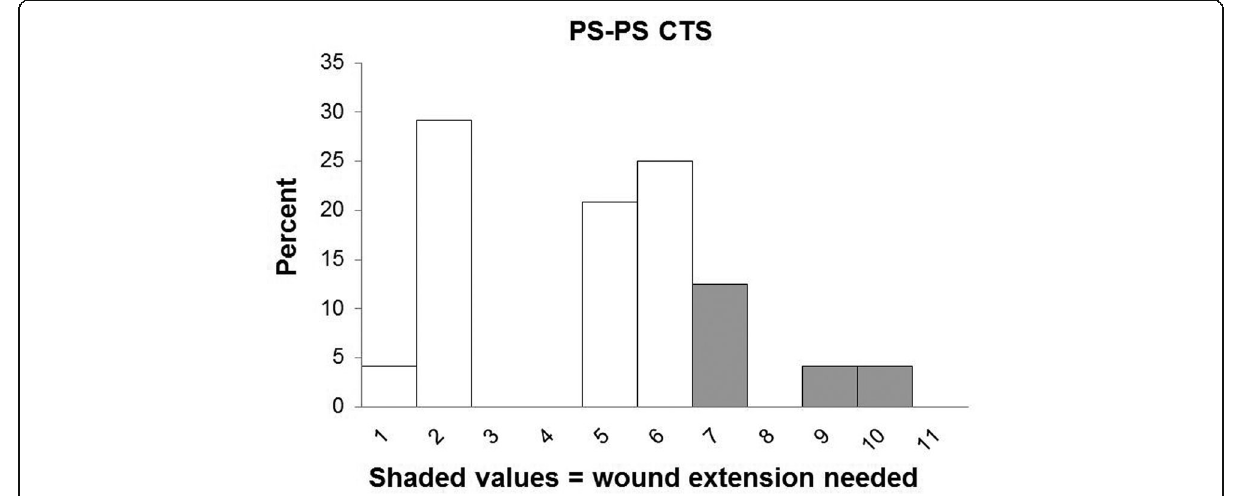
Fig. 4 Histogram of the cross sectional area difference and need for wound extension